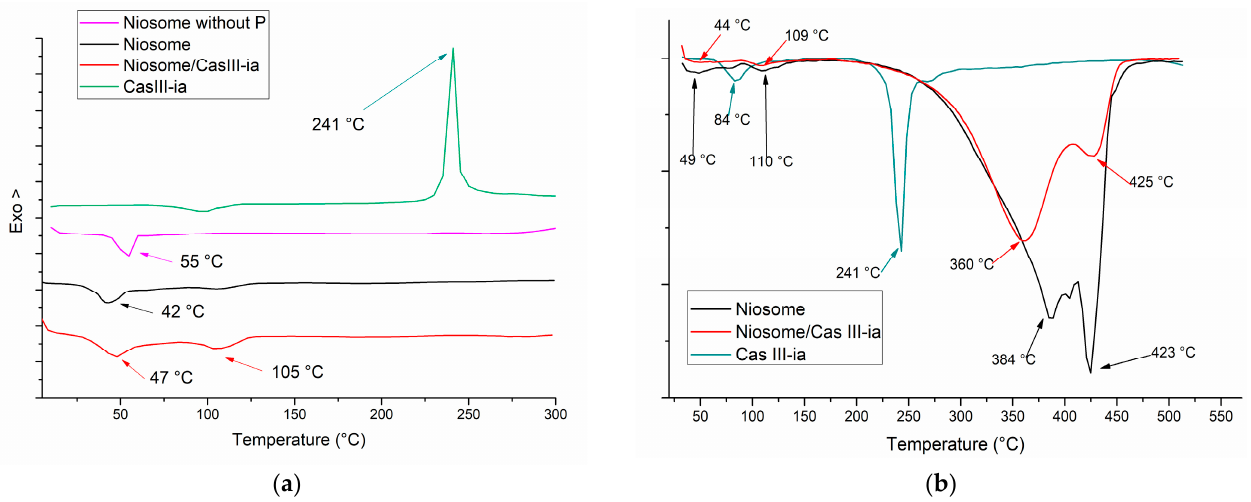
Figure 4. ( a ) DSC and ( b ) TGA thermogram of CasIII—ia, niosome with and without